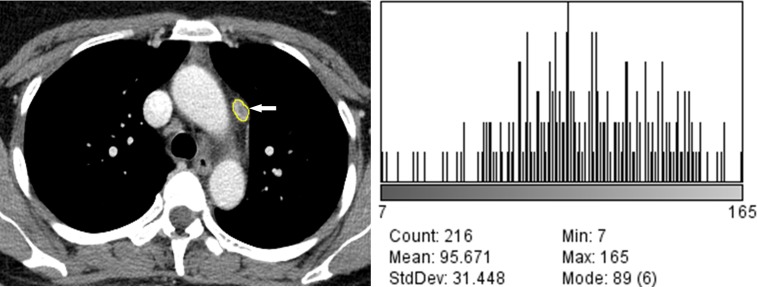
49-year-old woman with tuberculous lymphadenopathy without lung involvement.(A) Mediastinal window image of contrast-enhanced chest CT scan shows a segmented subaortic lymph node of the aortic group (arrow). (B) Histogram plot shows the CT data profile of the segmented lymph node (skewness, -0.43; kurtosis, 0.56).